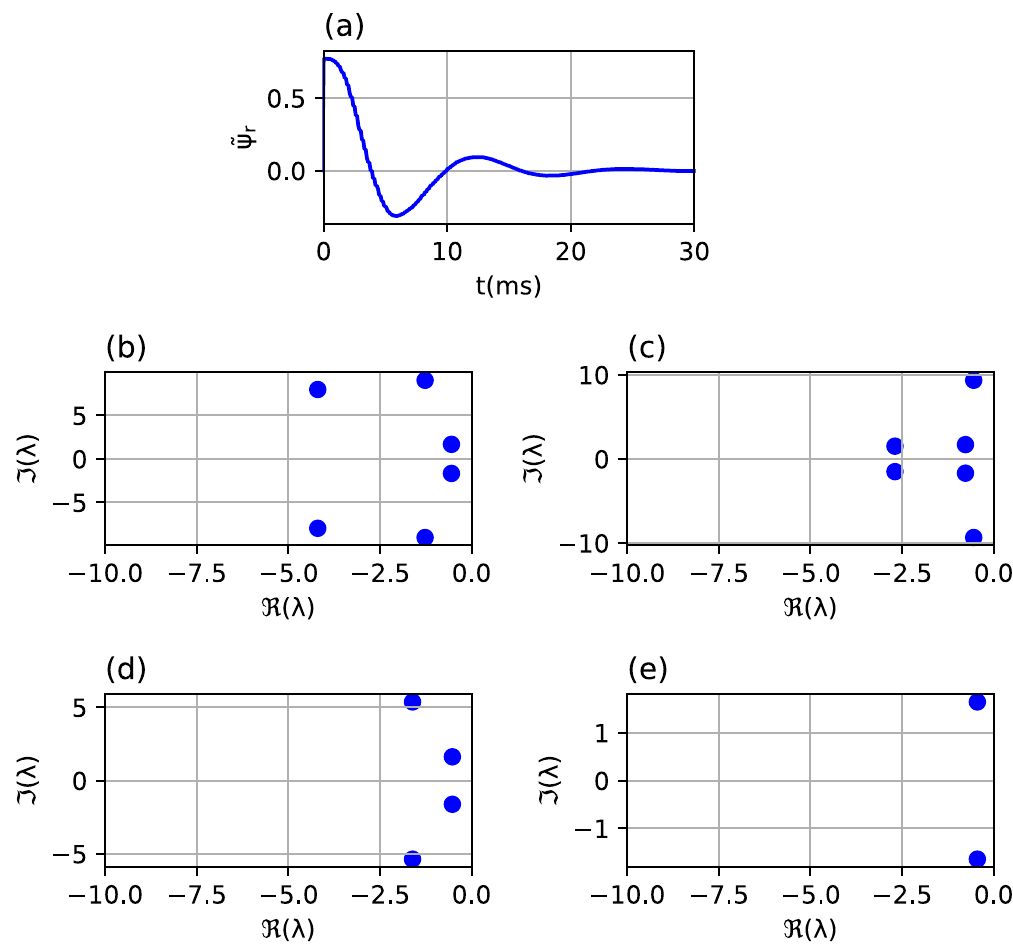
Figure 4. System order influence on observer dynamics identification for observer gains providing underdamped transient